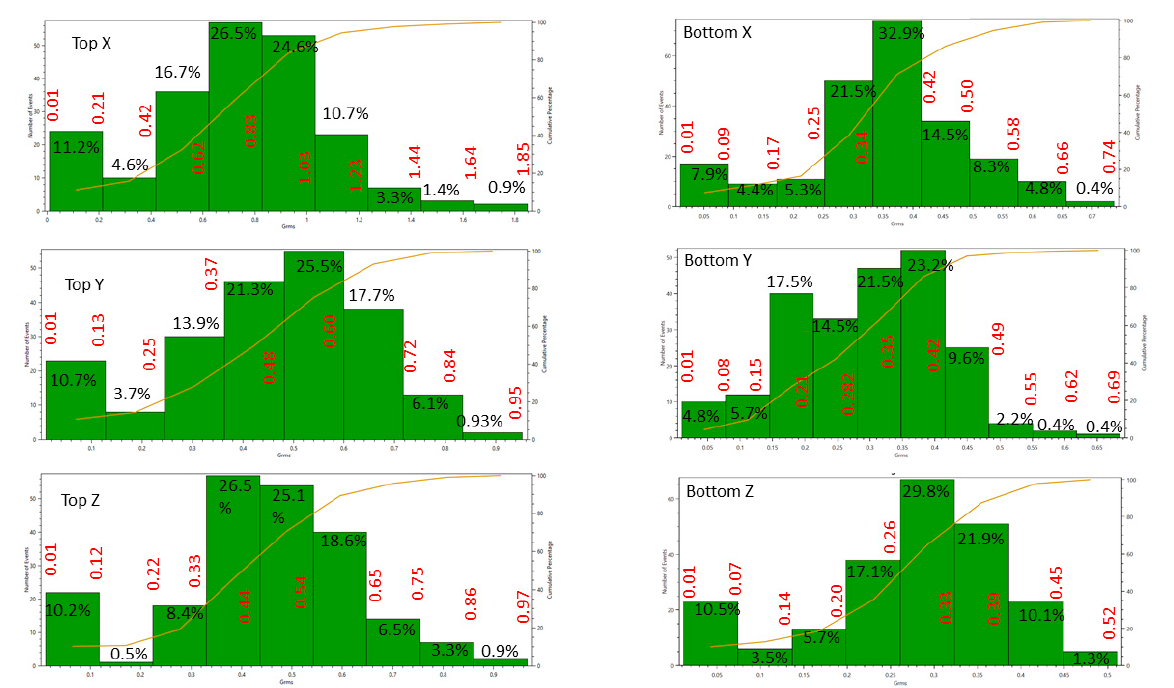
Figure 8. Vibration G rms histogram for DJI 600. Overall, the major vibration sources are inherited from the high-frequency motor and structure and not from the interaction between the drone and the airflow characterized by lower vibration frequency. This is different from the truck and railroad profiles where suspension to the